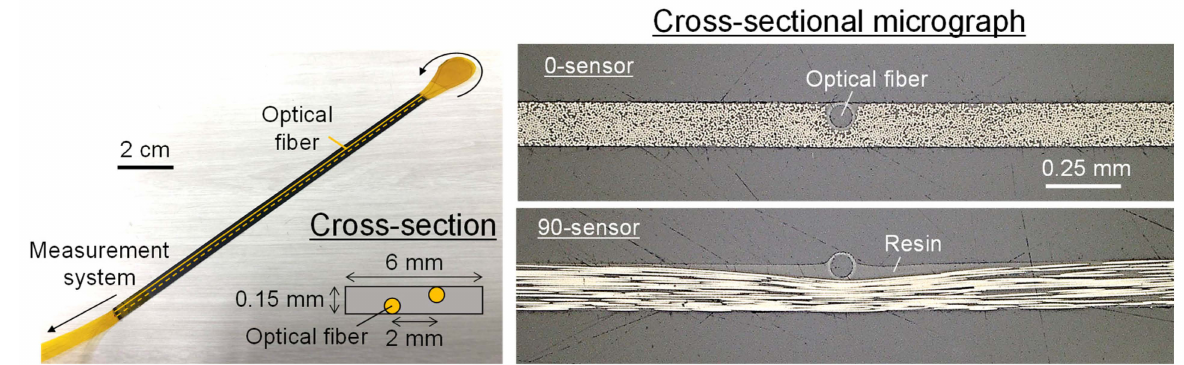
Figure 4. Strip-type shape sensors fabricated using carbon/epoxy prepreg.